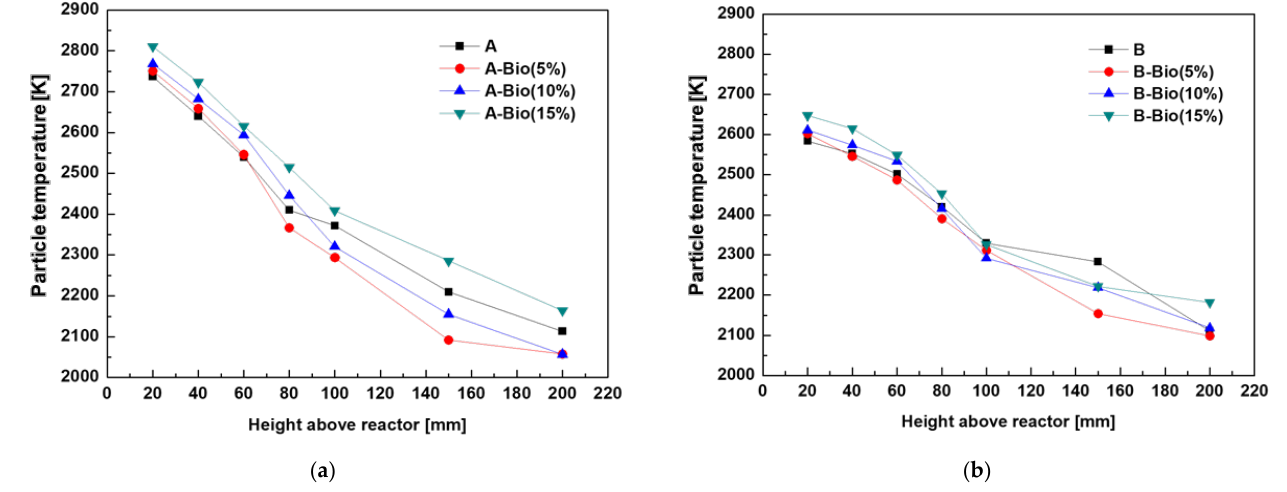
Figure 6. Particle – temperature distribution along the height above the reactor: ( a ) Coal A + bio- Figure 6. Particle–temperature distribution along the height above the reactor: ( a ) Coal A + biomass mass (0%, 5%, 10%, 15%) and ( b ) Coal B + biomass (0%, 5%, 10%, 15%). (0%, 5%, 10%, 15%) and ( b ) Coal B + biomass (0%, 5%, 10%,